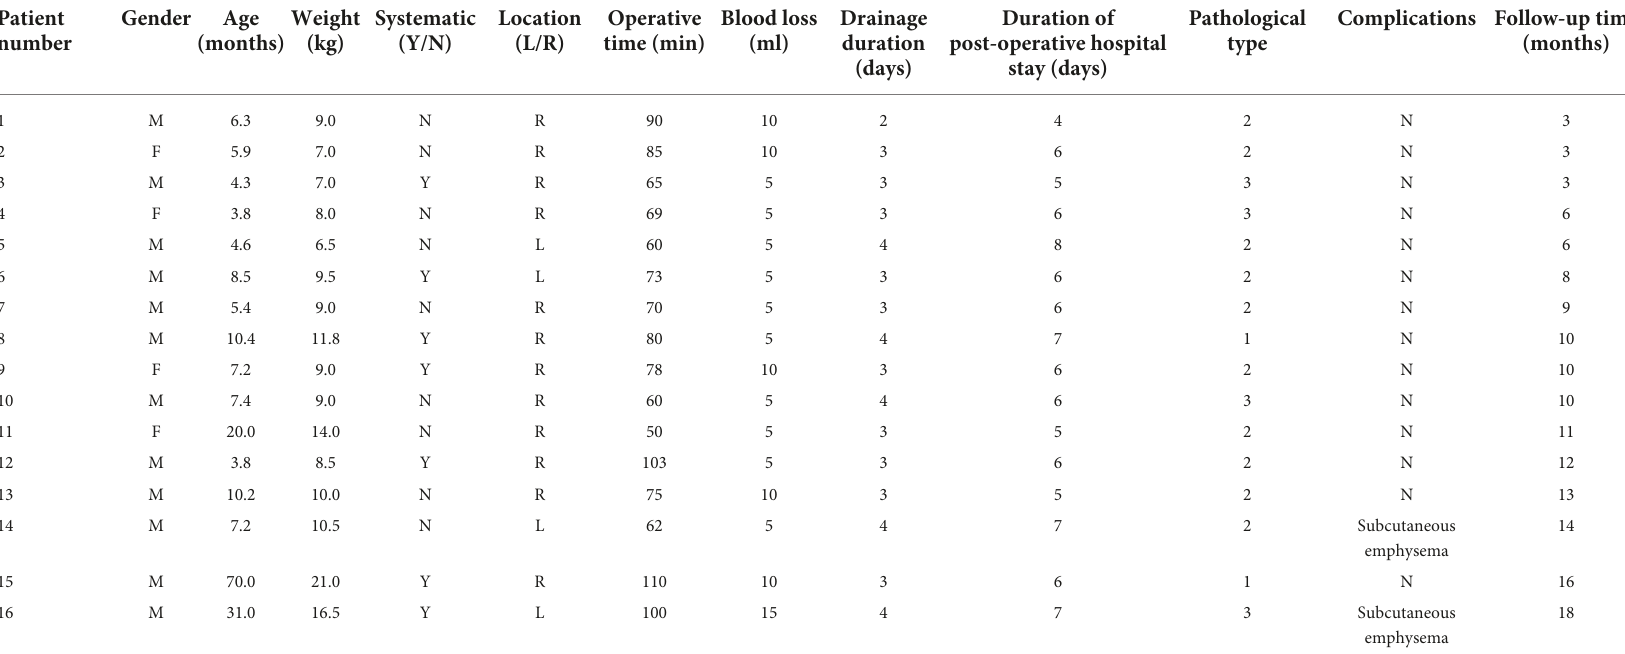
TABLE 1 Clinical data of children undergoing modified thoracoscopic wedge